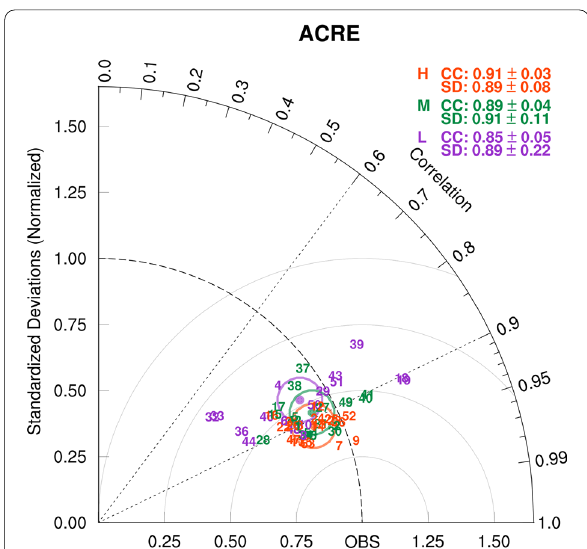
Fig. 3 The Taylor diagram summarizing the performance skills of ACRE simulations in 54 CMIP6 models against the CERES‑EBAF observations. The purple, green and orange circles denote the ensemble means of low‑, medium‑, and high‑resolution groups, respectively. The statistical information of ACRE for three different groups of CMIP6 models is presented at the top‑right